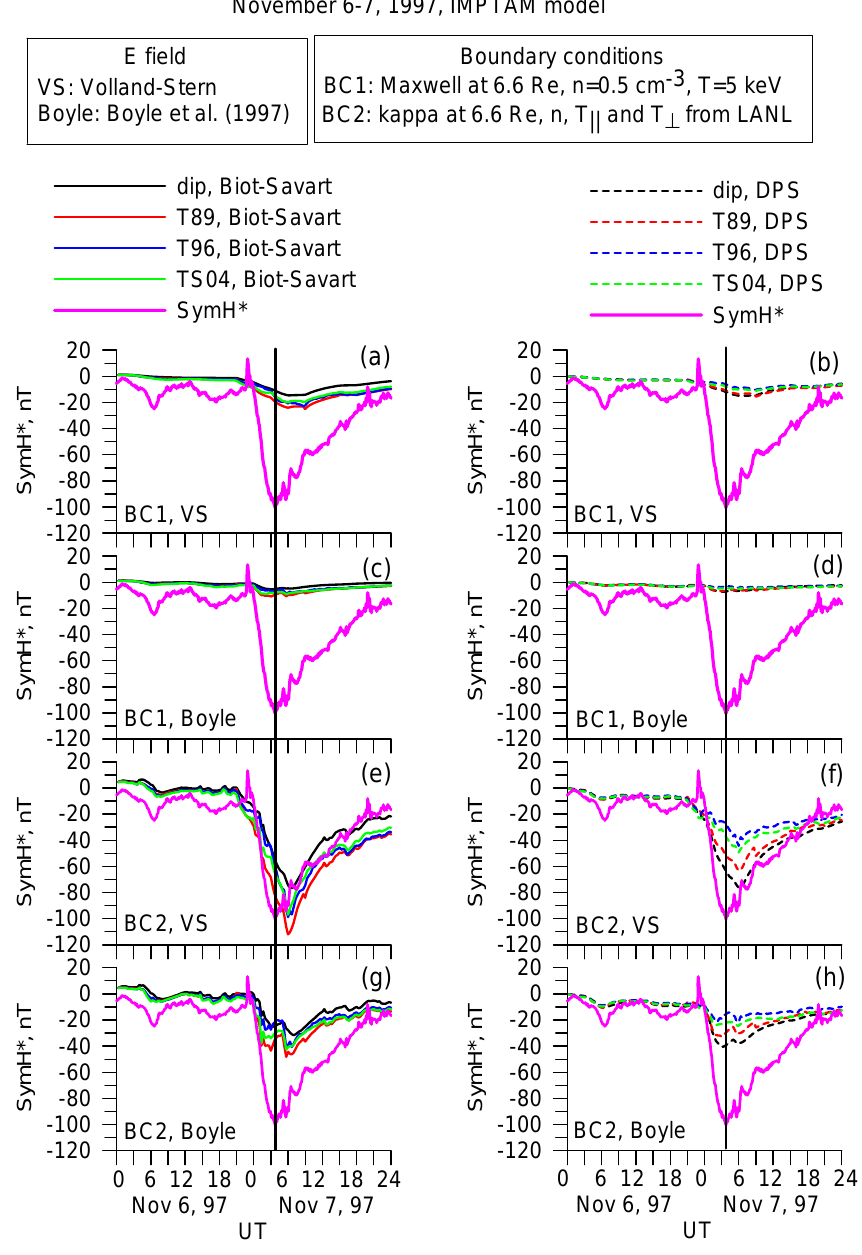
Fig. 8. Magnetic field depression at the center of the Earth produced by the modeled proton (1–300keV) distribution during 6–7 Novem- ber 1997 storm with boundary distribution at 6.6 R E . Calculations were made by using Biot-Savart’s law and Dessler-Parker-Sckopke relation. The observed corrected SymH* index is shown by thick purple lines. Thick black vertical lines mark the time moment of minimum in the observed SymH* index through all panels.